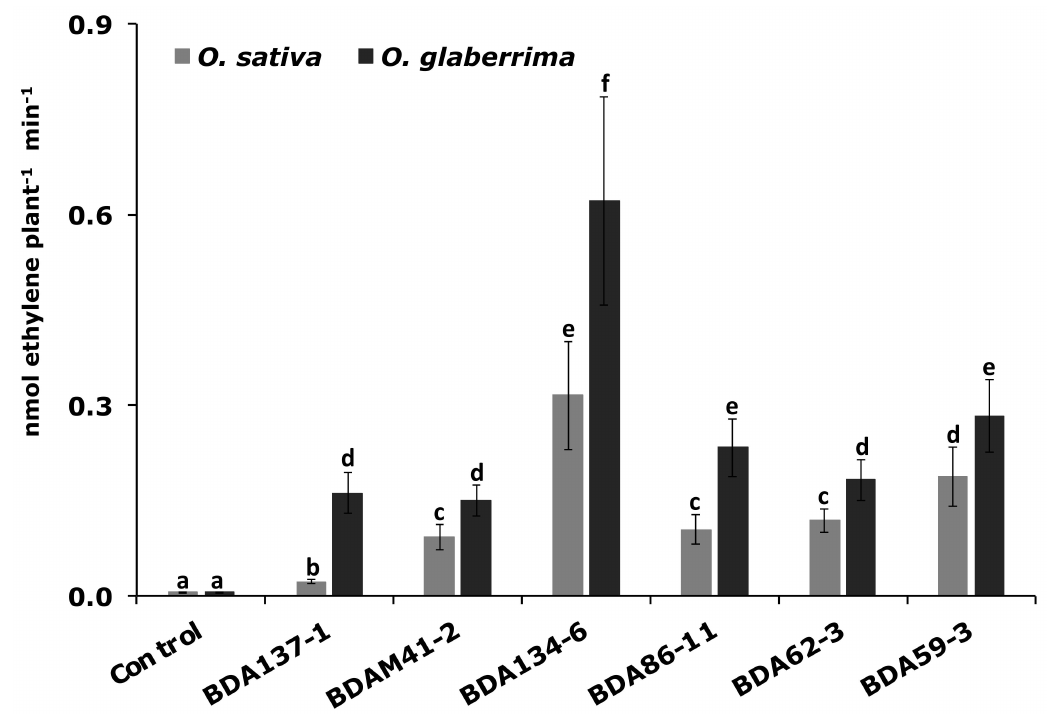
Figure 4. Nitrogenase activity in O. glaberrima RAM133 and O. sativa L. cv. Baldo plants inoculated with N-fixing endophytes. Two-week-old rice plants of primary ( O. glaberrima ) and secondary ( Oryza sativa ) inoculated host were carefully removed from the pots and used for the ARA test. Data are the means ± SD of at least six independent biological replicates each carried out at different times. Means with different letters are significantly different at 5% level of confidence (Tukey’s post hoc